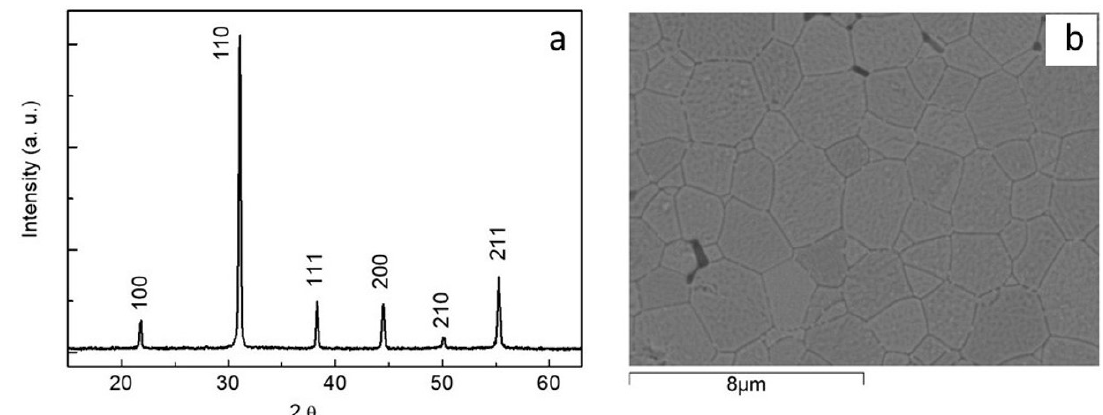
Figure 2. The XRD diffraction spectra (a), and cross-section SEM image (b) of 9/65/35 PLZT